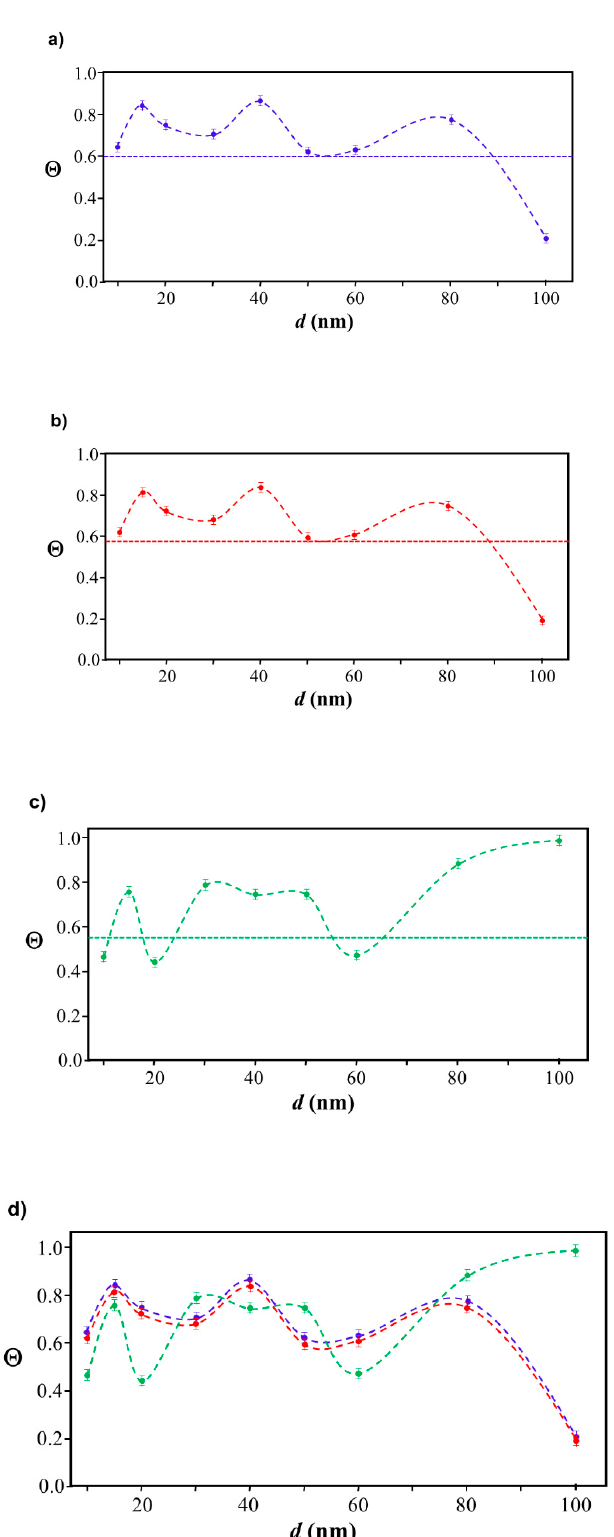
Figure 3. A plot for experimentally obtained Θ for ( a ) A β 1–40 in blue ( b ) α -syn in red, and ( c ) β 2m in green as a function of reported gold diameter d (nm). All data points were extracted by using Equation (2). Each dashed curve line is simulated by a method described in Section 4.3.3 with the parameters tabulate in Table 2. The dotted line shows an upper limit of the Θ value obtained by a single layer model. ( d ) The over-laid plots of all ( a – c ) are shown, and indicating ( a , b ) almost overlay each